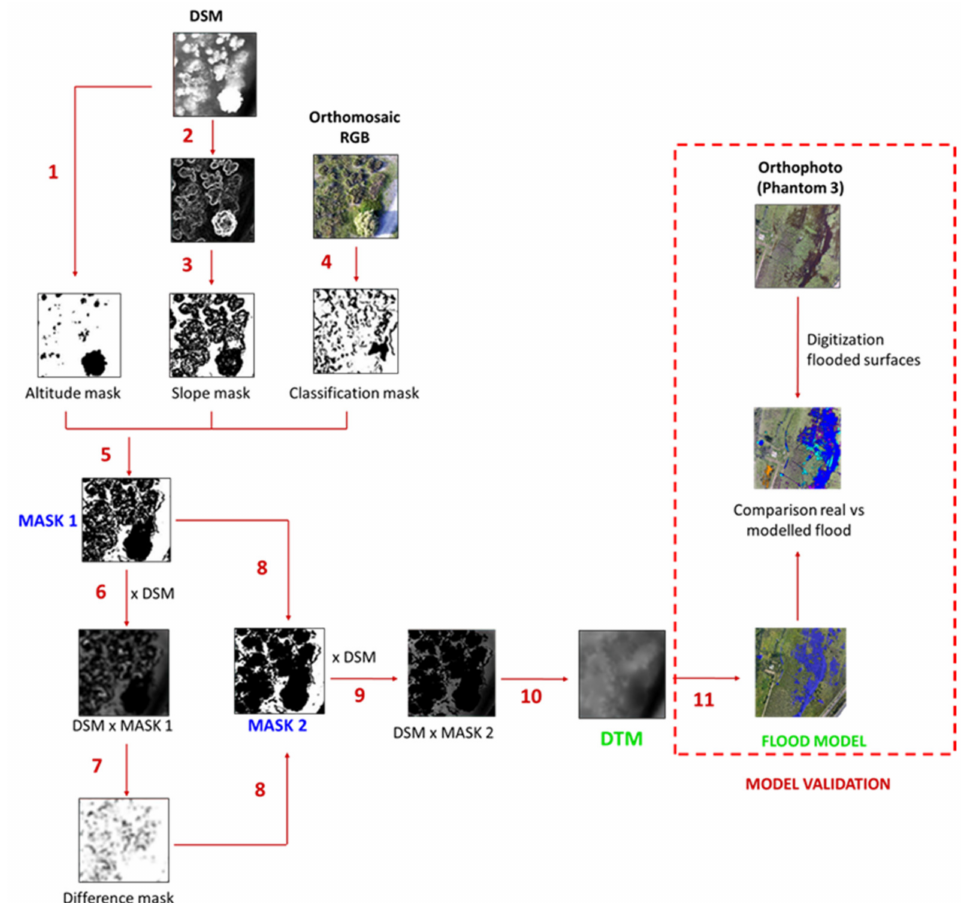
Figure 5. Image processing